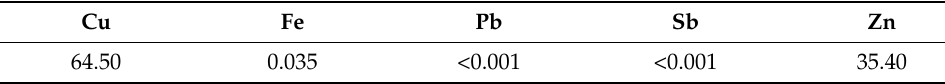
Figure 1. Schematic of the rotary ring spinning forming process and experimental equipment: (a) Schematic; (b) equipment. Table 1. Chemical composition of H65 (weight fraction (%)).